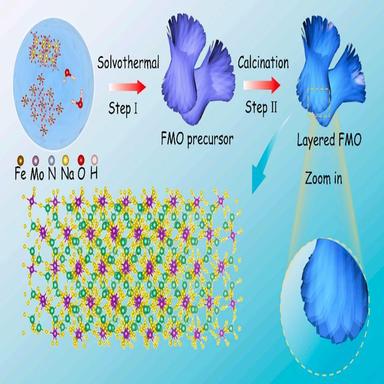
Schematic illustration of the synthetic process of the L-FMO assemblies.